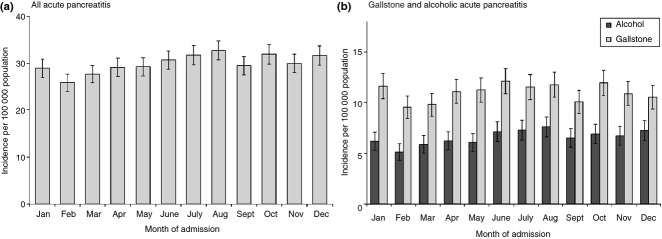
Incidence of acute pancreatitis (per 100 000 population) according to the month of the admission, in Wales from 1999 to 2010, for (a) All acute pancreatitis. (b) Gallstone and alcoholic acute pancreatitis. Incidence is standardised for age group and gender. Vertical bars represent 95% confidence intervals.